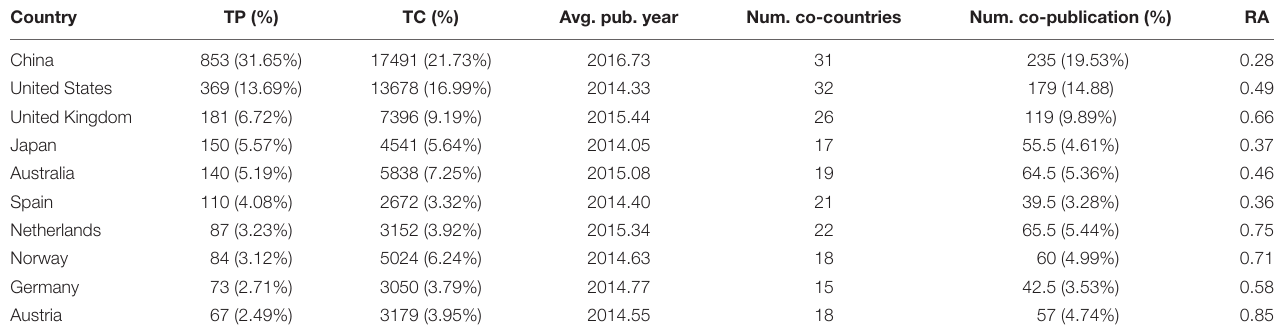
TABLE 1 | Top 10 countries (regions) in cumulative